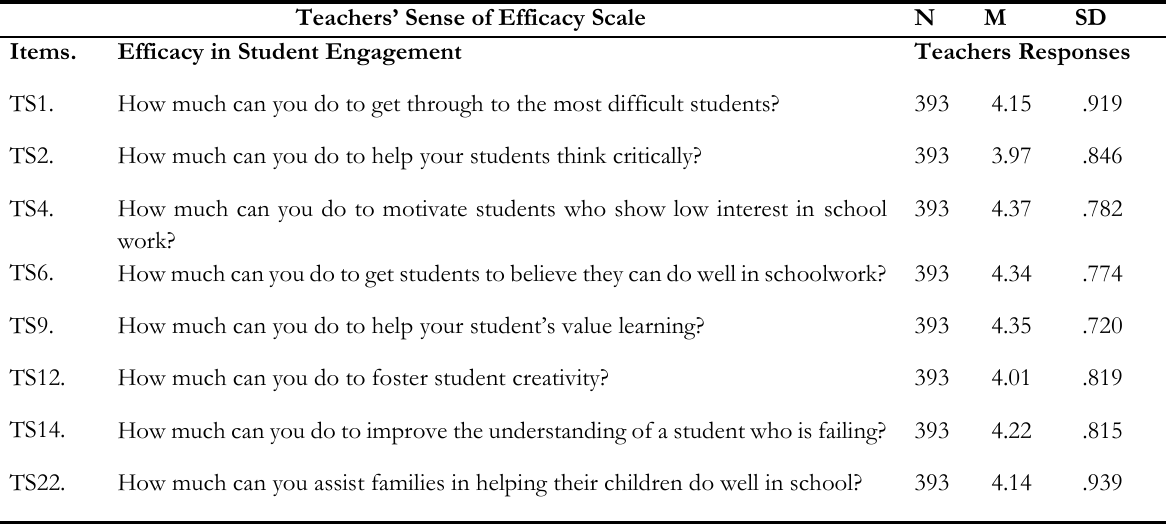
Table 1: Descriptive Statistics for 1 st Factor of Teachers’ Sense of Efficacy Teachers’ Sense of Efficacy Scale N M SD Efficacy in Student Engagement Teachers Responses